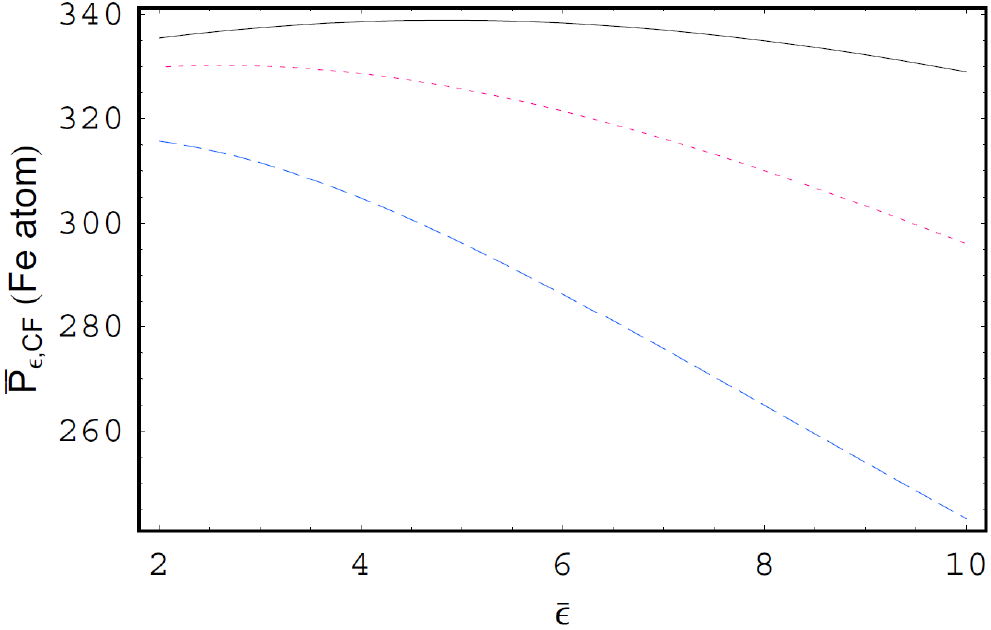
cn e n a ] Figure6. TheCoulombfocusedbremsstrahlungemissionrate P ε , CF inunitsof P 0 [ = ( 32/3 π 1/2 ) r 2 0 Figure 6. The Coulomb focused bremsstrahlung emission rate , CF P ε in units of as a function of the scaled photon energy ε for the W atom when E 0 = 15 including the influence of 1/2 2 [ (32 / 3 ) ] P r cn n π= as a function of the scaled photon energy ε for the W atom when Coulomb focusing. The solid line is the case of the thermal case, i.e., κ → ∞ . The dotted line is the e a 0 0 15 E = including the influence of Coulomb focusing. The solid line is the case of the thermal case, case of κ = 3. The dashed is the case of κ = 0 κ→ ∞ κ = κ = i.e., . The dotted line is the case of 3 . The dashed is the case of 2 .